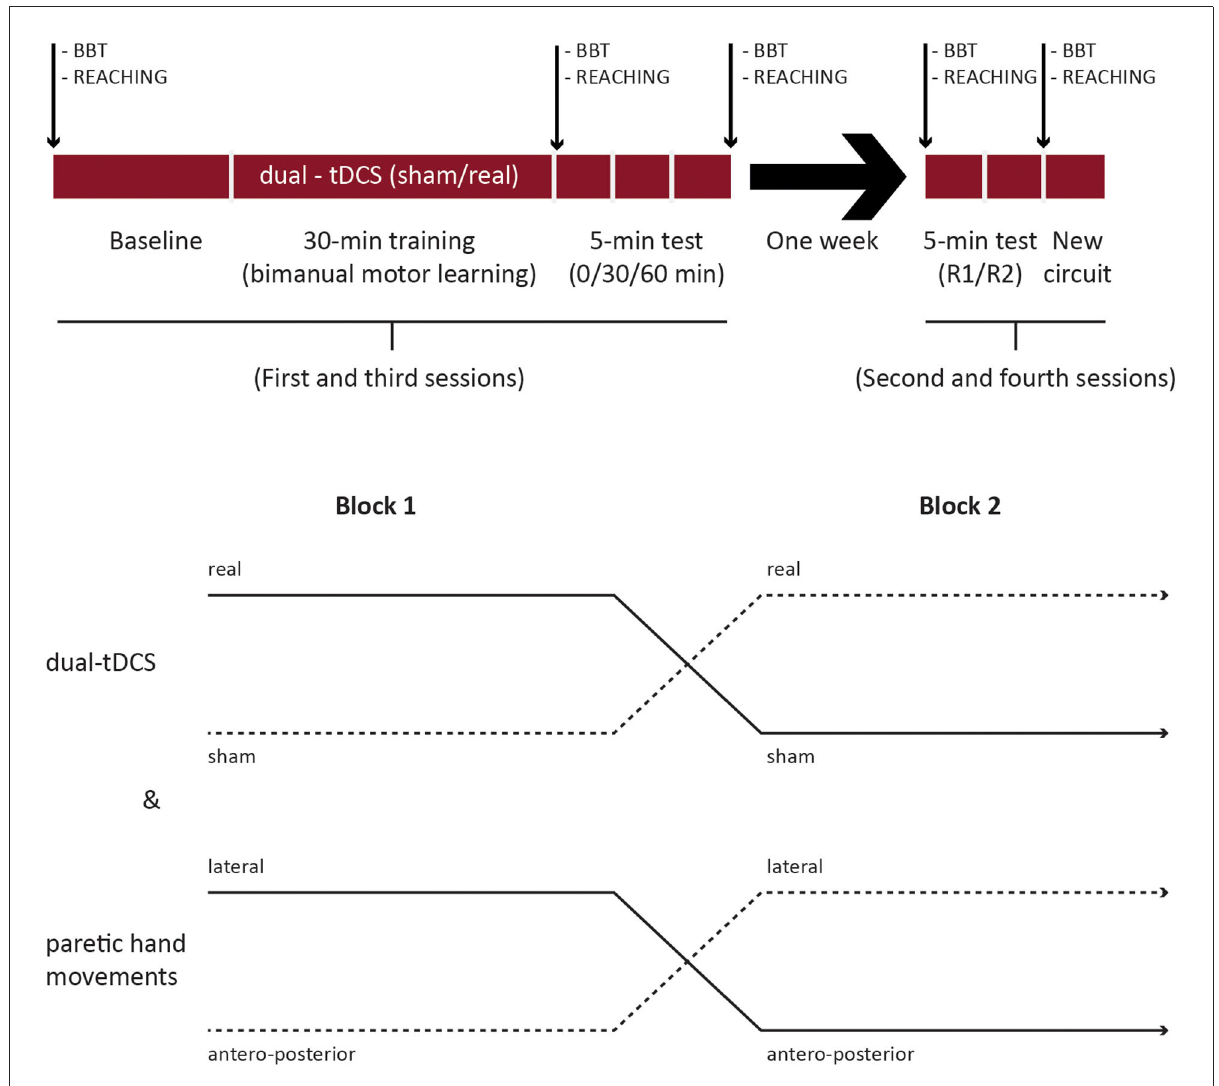
FIGURE1 Study design. BBT, box and blocks test; R1/R2, retentions 1 and 2, respectively; new circuit: